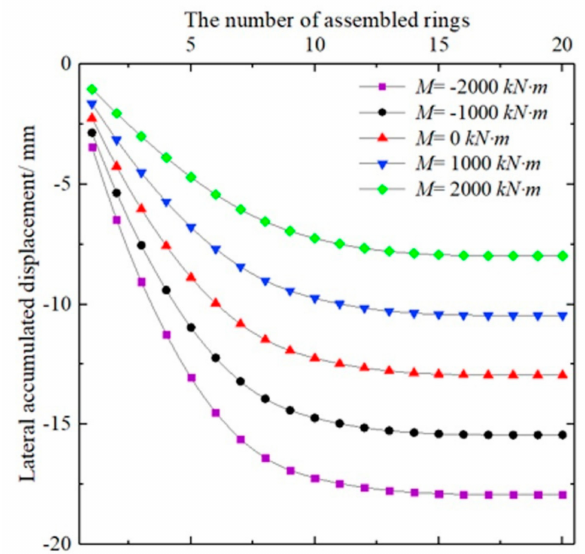
Figure 10. Lateral accumulated displacement curves of the first 20 assembled rings under di ff erent thrust misalignments.